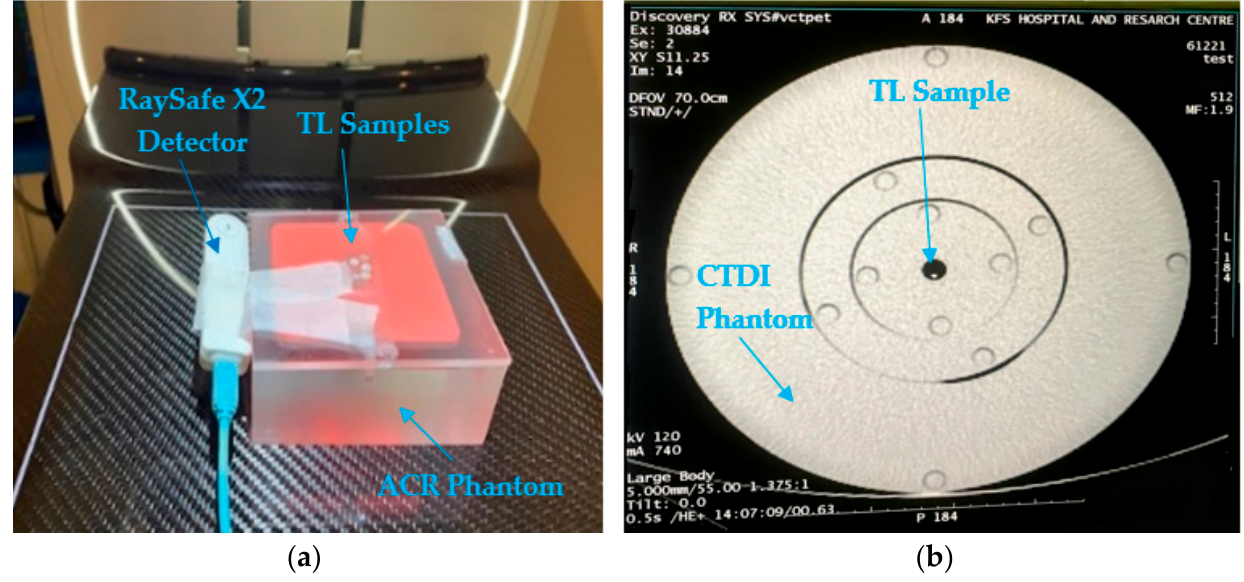
Figure 3. ( a )TLD irradiation from mammography and ( b ) CT image of TLV17 and TLV30 inside Figure 3. ( a ) TLD irradiation from mammography and ( b ) CT image of TLV17 and TLV30 inside CTDI phantom. CTDI